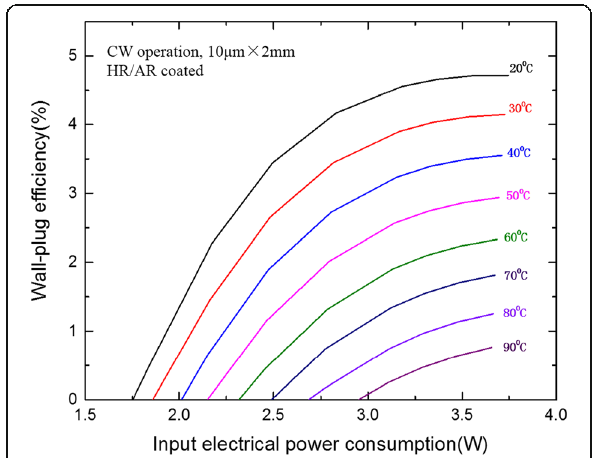
Fig. 6 Wall-plug efficiency as a function of the electrical power dissipation for the 2-mm-long HR and AR-coated